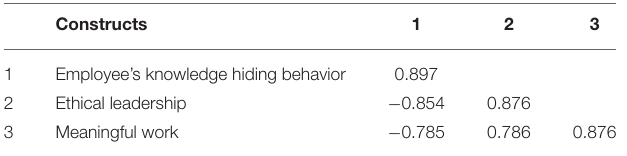
TABLE 4 | Discriminant